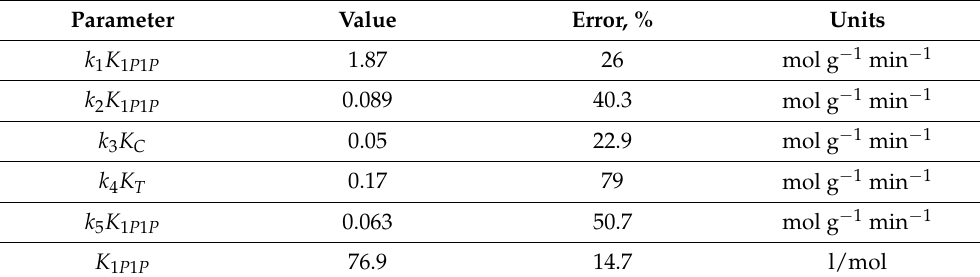
Table 2. Values of kinetic parameters for hydrogenation of 1-phenyl-1-propyne over Pd SAA catalyst. Parameter Value Error,